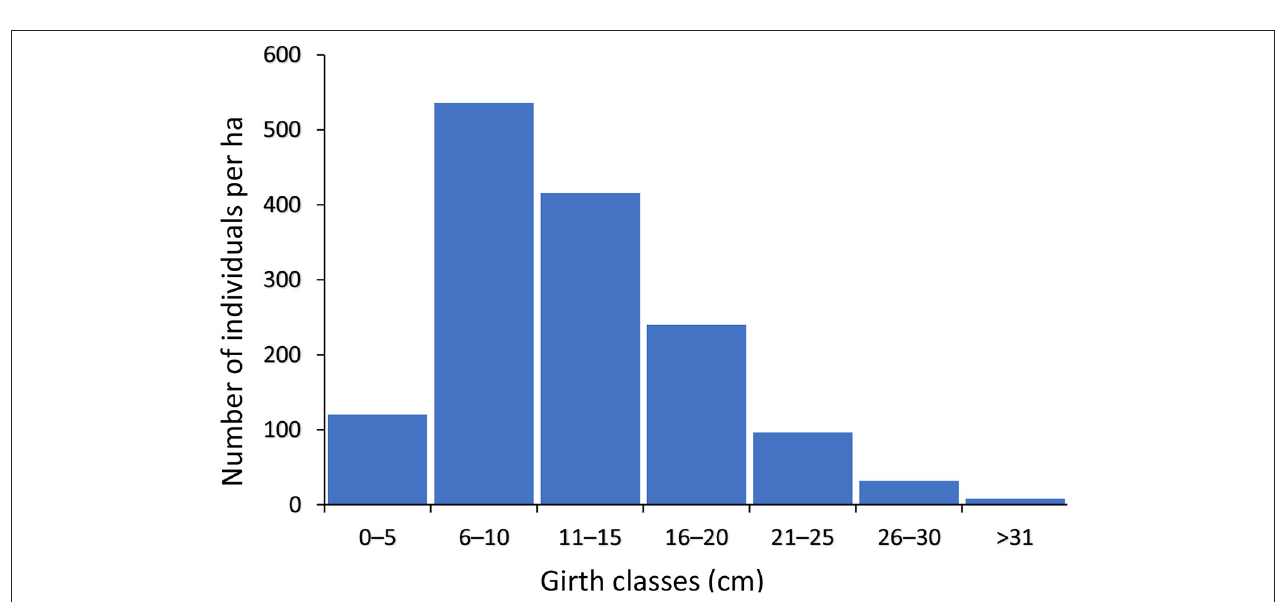
FIGURE 3 | Girth frequency distribution of shrubs (low woody perennials generally < 5m height) measured at 2cm above ground in the broad-leaf mixed coniferous forest of Tshothang Chiwog, Bhutan.